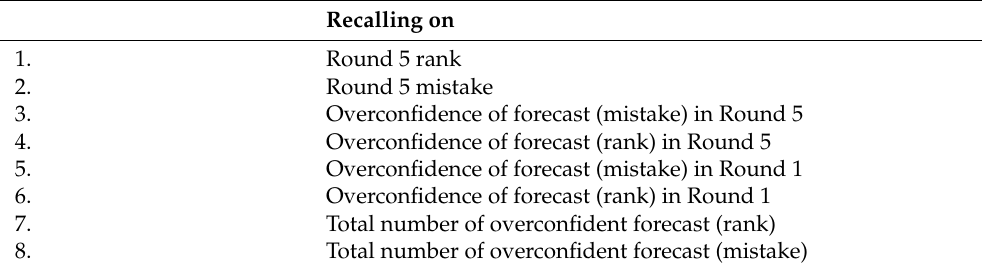
Table 1. Summary of Memory Recall Questions.